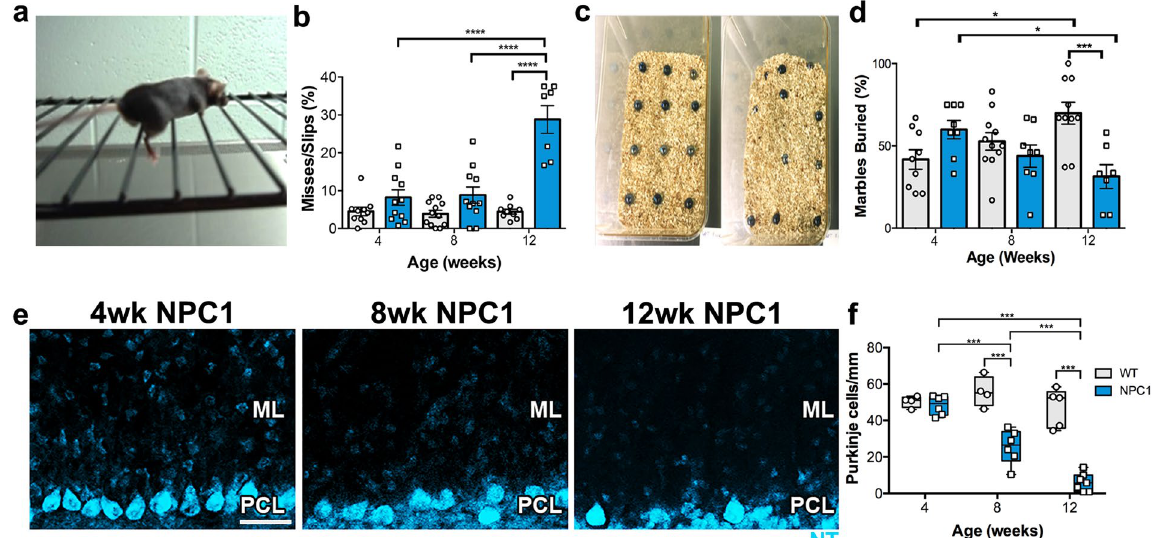
Figure 1. Motor deficits occur along severe loss of PCs in the Npc1 nmf164 mouse. ( a ) Representative photograph illustrating a mouse in the ladder while one of its legs slipped between rungs. ( b ) Motor impairments in Npc1 nmf164 mice when performing the ladder rung task at 4 (WT n = 10, NPC1 n = 11), 8 (WT n = 12, NPC1 n = 11), and 12 (WT n = 9, NPC1 n = 7) weeks of age. Quantifications of the percentage of misses and slips showed significant increases at 12 weeks of age in Npc1 nmf164 mice when compared to WT mice. ( c ) Representative photograph illustrating the arrangement of marbles in the cage before (left) and after (right) the marble burying test. ( d ) Increased percentage of buried marbles at the early stage (4 wks) in Npc1 nmf164 mice, while a significant decrease is observed at the severe stage of PCs degeneration (12 wks) when compared to WT mice (n = 7–10). ( e ) PCs stained with Neuro Trace TM (NT) fluorescent nissl stain at 4, 8 and 12 weeks of age in Npc1 nmf164 mice. ( f ) The linear density of PCs significantly decreased with age in regions from the first four lobules of the anterior cerebellum in Npc1 nmf164 mice. No changes in the density of PCs were found between WT mice at 4, 8 and 12 weeks of age (n = 3–4 per age). Data are presented as mean ± SEM, 4 wk NPC1 (n = 6), 8